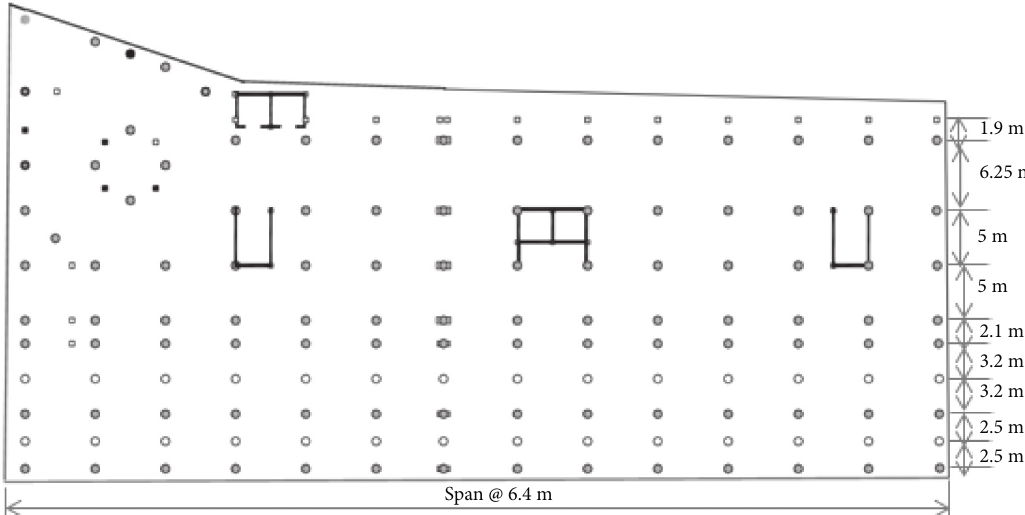
Figure 5: Case 2 piled raft layout.